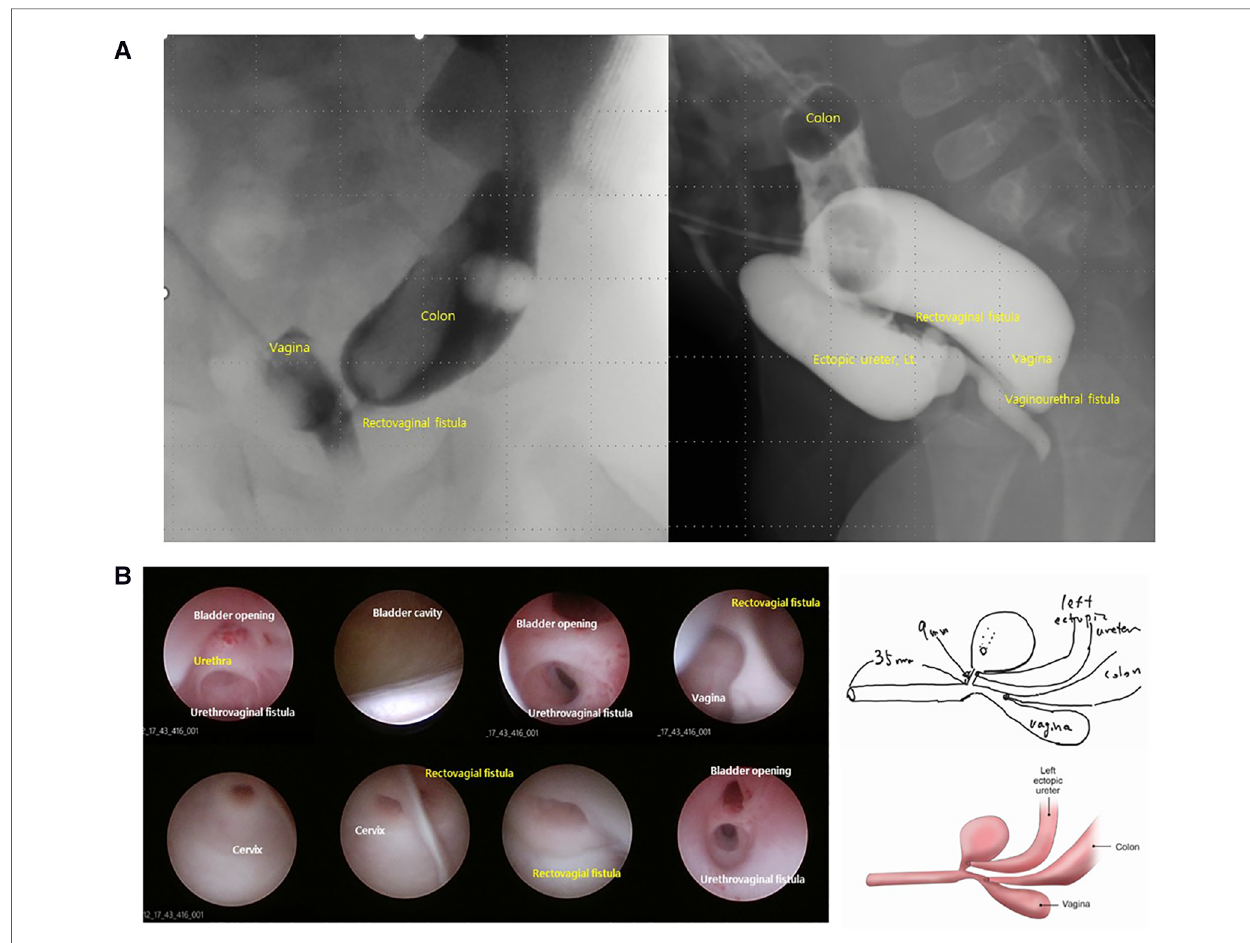
FIGURE 1 Images of distal loopogram ( A ) and endoscopy ( B ). Distal loopogram revealing the fi stula location and spatial relationship between each cloacal structure. Loopography provides limited information on the exact size or location of individual structures. Similarly, endoscopy alone is unable to accurately determine the size or position of individual structures. This schematic based on endoscopic fi ndings demonstrates the limitations of